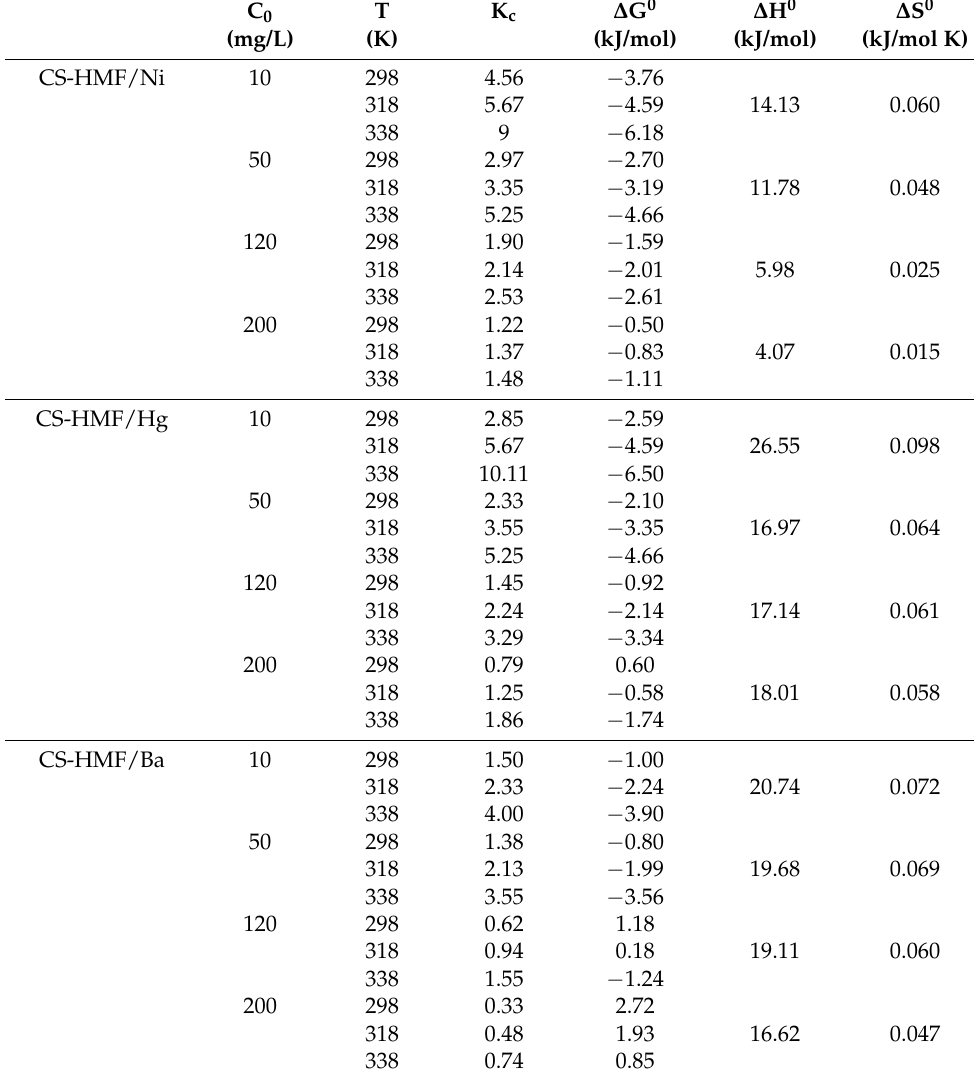
Table 5. Thermodynamic parameters for the uptake of Ni 2+ , Hg 2+ , and Ba 2+ from aqueous solutions (single